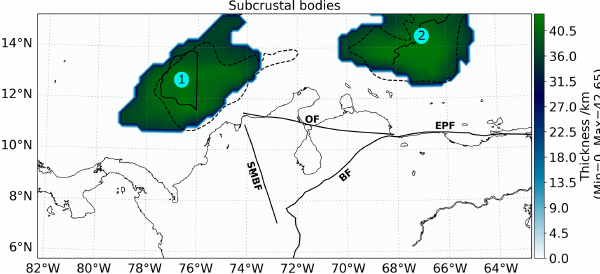
Figure 10. Two high-density subcrustal bodies are required to fit the gravity field. These bodies have a spatial correlation with the thin crust in the Colombian and the Venezuelan basins. Polygons are as described in Fig. 8. Acronyms are the same as in Fig.